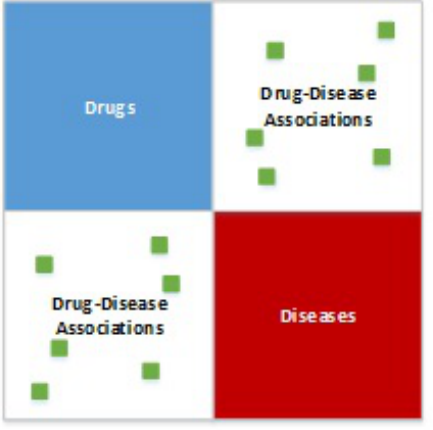
Fig. 2 Association matrix.